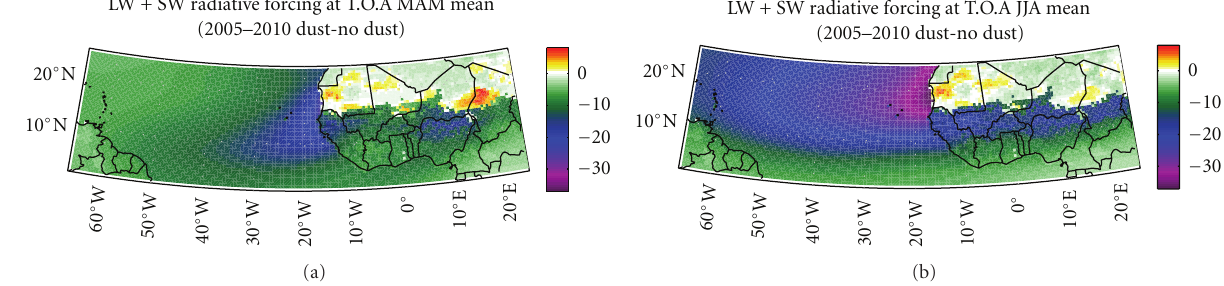
Figure 10: Solar radiation forcing (Longwave and shortwave) in W/m 2 due to the presence of dusts at the top of the atmosphere.